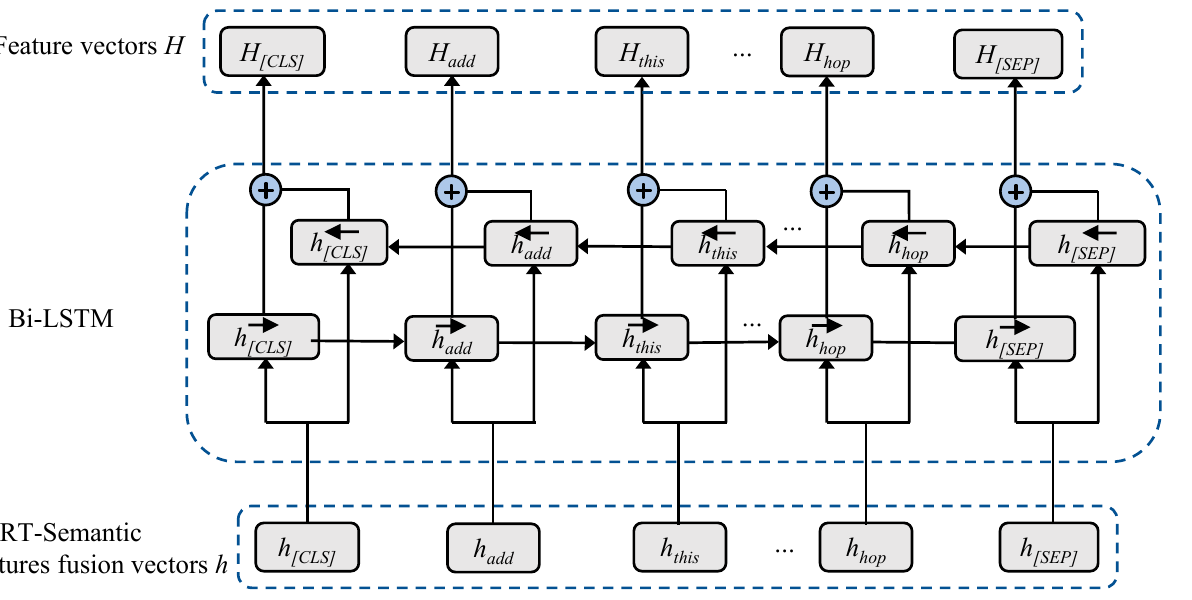
Figure 3. Bi-LSTM layer.